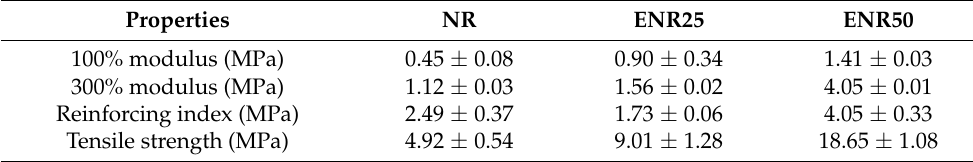
Table 5. Mechanical properties of NR-Clay, ENR25-Clay and ENR50-Clay composites.